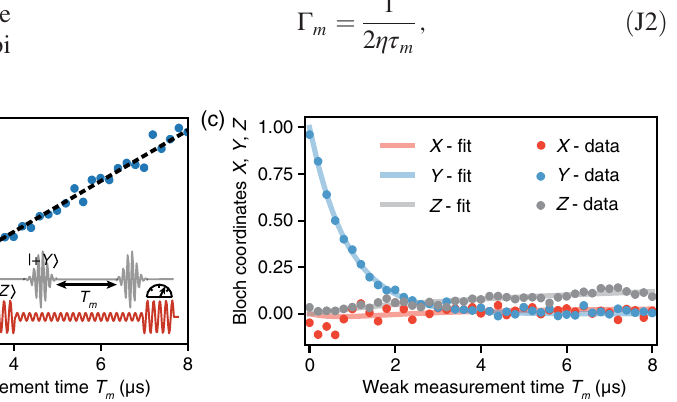
FIG. 13. (a) Histograms of the integrated voltage records conditioned on the projective measurement result after preparing the qubit in j þ Y i and T m ¼ 2 . 0 μ sofweak measurement.Thehistograms separate byanamount Δ V duetocollapseofthewavefunctionasaresultof theweakmeasurement.(b)Thenormalizedseparation S ¼ ð Δ V= σ Þ 2 increaseslinearlywiththeweakmeasurementtimeandtheslopegives thecharacteristicmeasurementtime τ .Theinsetshowsapulsesequenceusedforthiscalibrationmeasurement.(c)Toextracttheefficiency m Γ − 1 wefittheexponentialdecayoftheprojectivemeasurementsinthe Y basis(blue),whichgives T ¼ 0 . 91 μ s,or Γ d = 2 π ¼ 0 . 175 d ¼ d